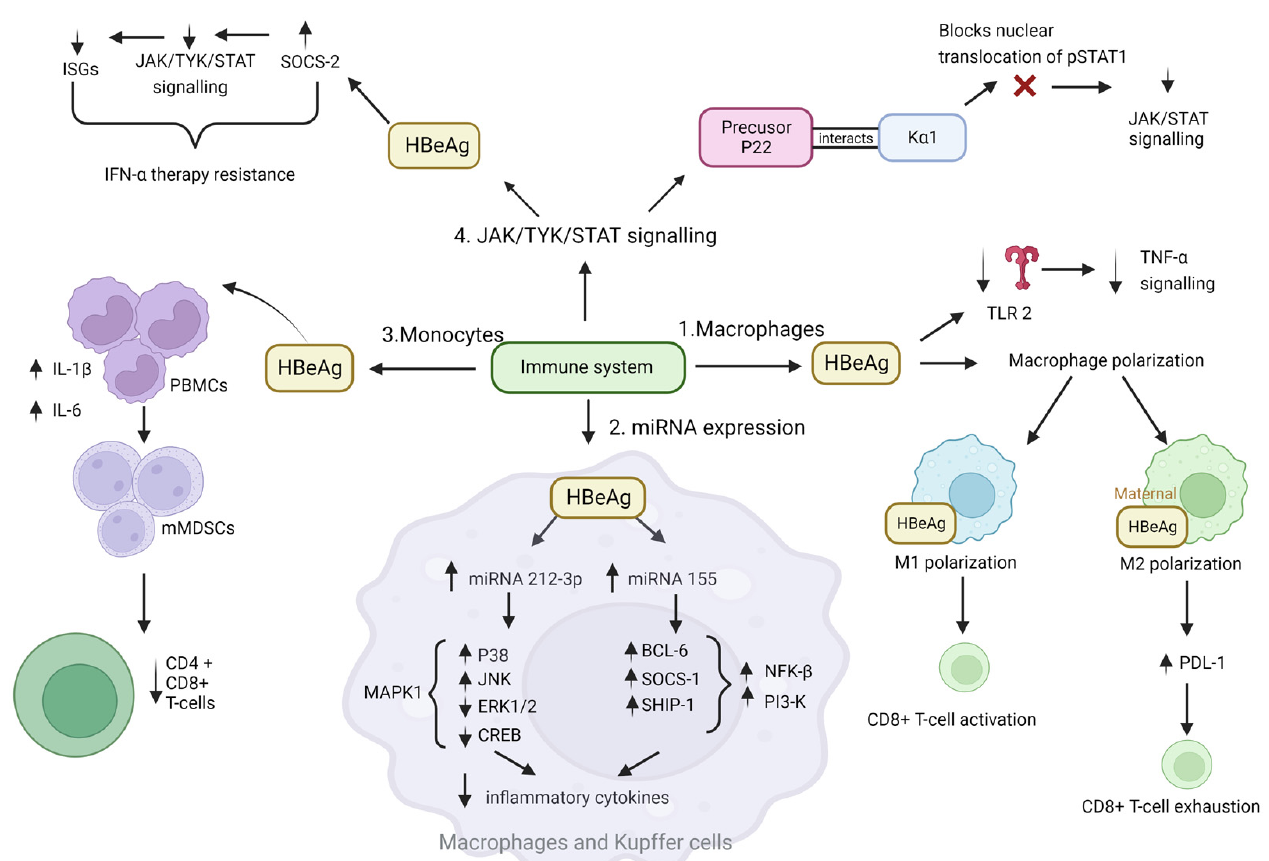
Figure 3. The role of HBeAg in immune evasion : in fl uence of HBeAg on di ff erent components of